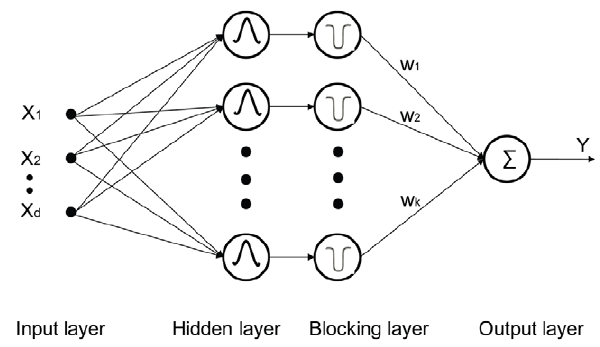
Figure 2. Conventional RBF architecture.